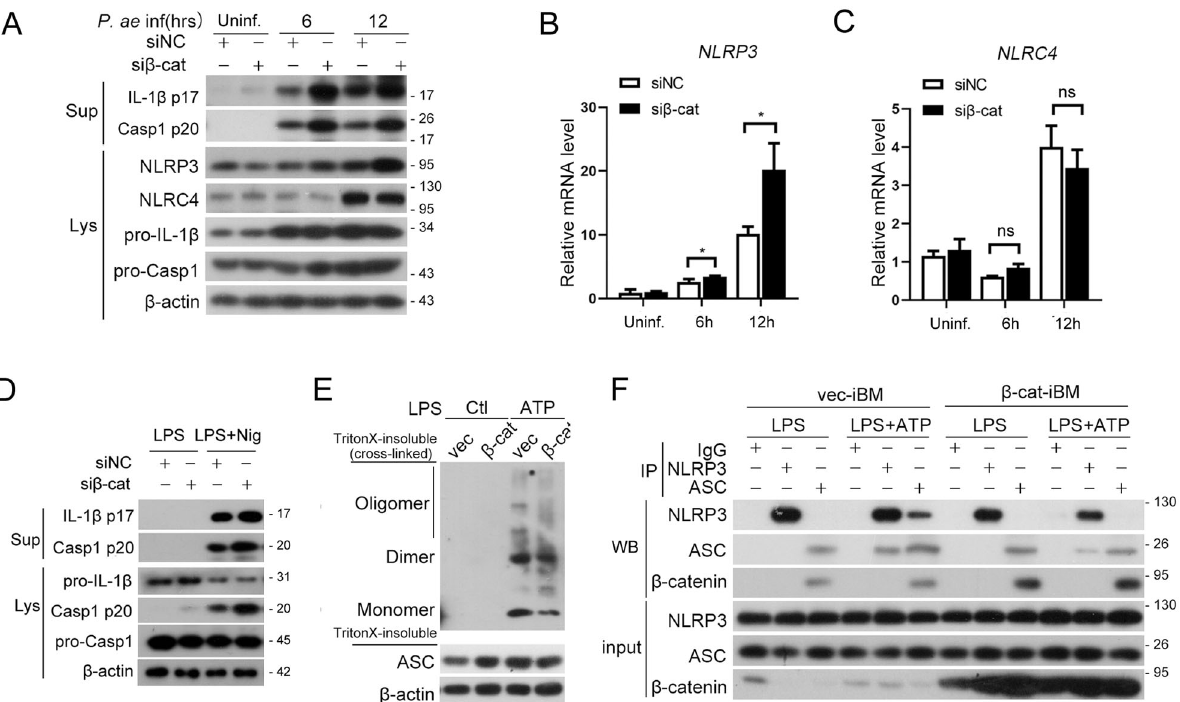
Fig. 6 β -catenin suppresses NLRP3 in fl ammasome activation. A – C WT BMDMs were transiently transfected by si β -catenin vs. siNC, and then infected by Pseudomonas aeruginosa (MOI = 1) for indicated times. D si β -cat or siNC transfected BMDMs were treated with LPS or LPS plus Nigericin (10 μ M) for 1 h. E vec-iBM or β -cat-iBM were stimulated with LPS (100 ng/ml, 3 h) or LPS plus ATP (4 mM, 1 h), and then cell lysates were detected by ASC oligomerization assay. F vec-iBM or β -cat-iBM were stimulated with LPS (100 ng/ml, 3 h) or LPS plus ATP (4 mM, 1 h), and then cells were collected and analyzed by co-immunoprecipitation using anti-NLRP3 or anti-ASC Ab or relative IgG isotypes. A , D , E , F Protein levels of indicated molecules in cell lysates or supernatants of each group were detected by western blot. B mRNA levels of NLRP3 and NLRC4 were detected by real-time PCR. Data are representative of at least three experiments. Error bars represent the mean ± SEM. * P < 0.05; ** P < 0.01; *** P < 0.001, ns no signi fi